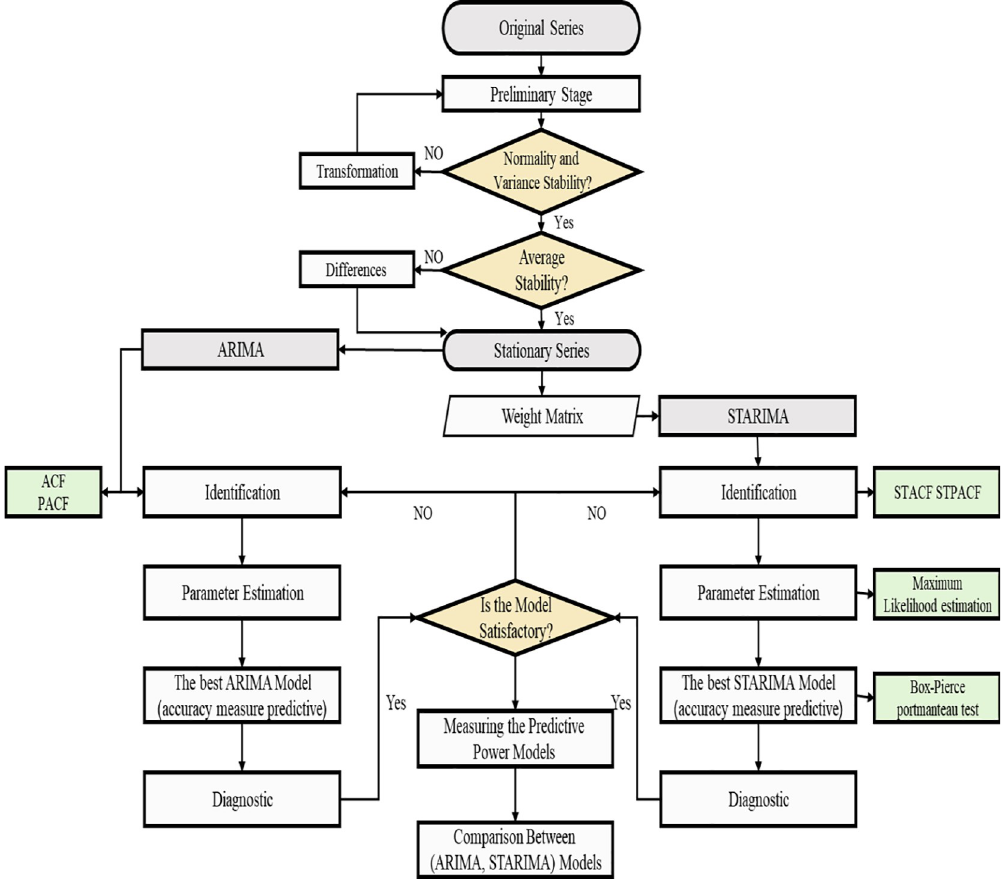
Fig 1. Applied study steps for ARIMA and STARIMA